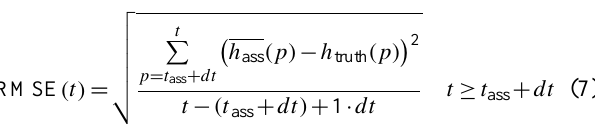
Fig. 9. Stage hydrographs at the cross section Lintgen with the 2 assimilation time steps (bottom panel) considering the RSD water level intervals assimilated through a uniform distribution: the fore- casting performance is illustrated with the RMSE evolution in time (top panel). The cyan line represents the RMSE before assimilation and the black line displays the RMSE after